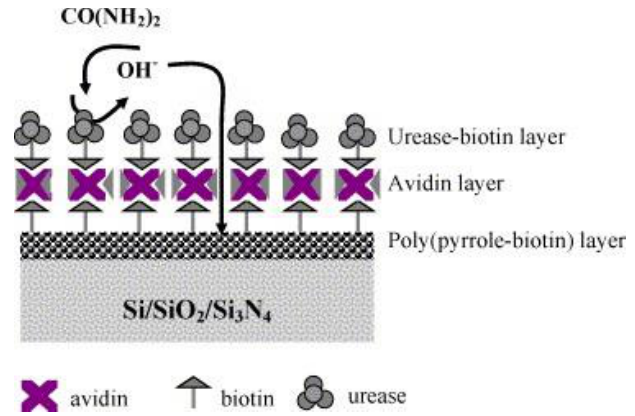
Figure 2. Schematic of the assembled multi-layer system. Reprinted from [28].